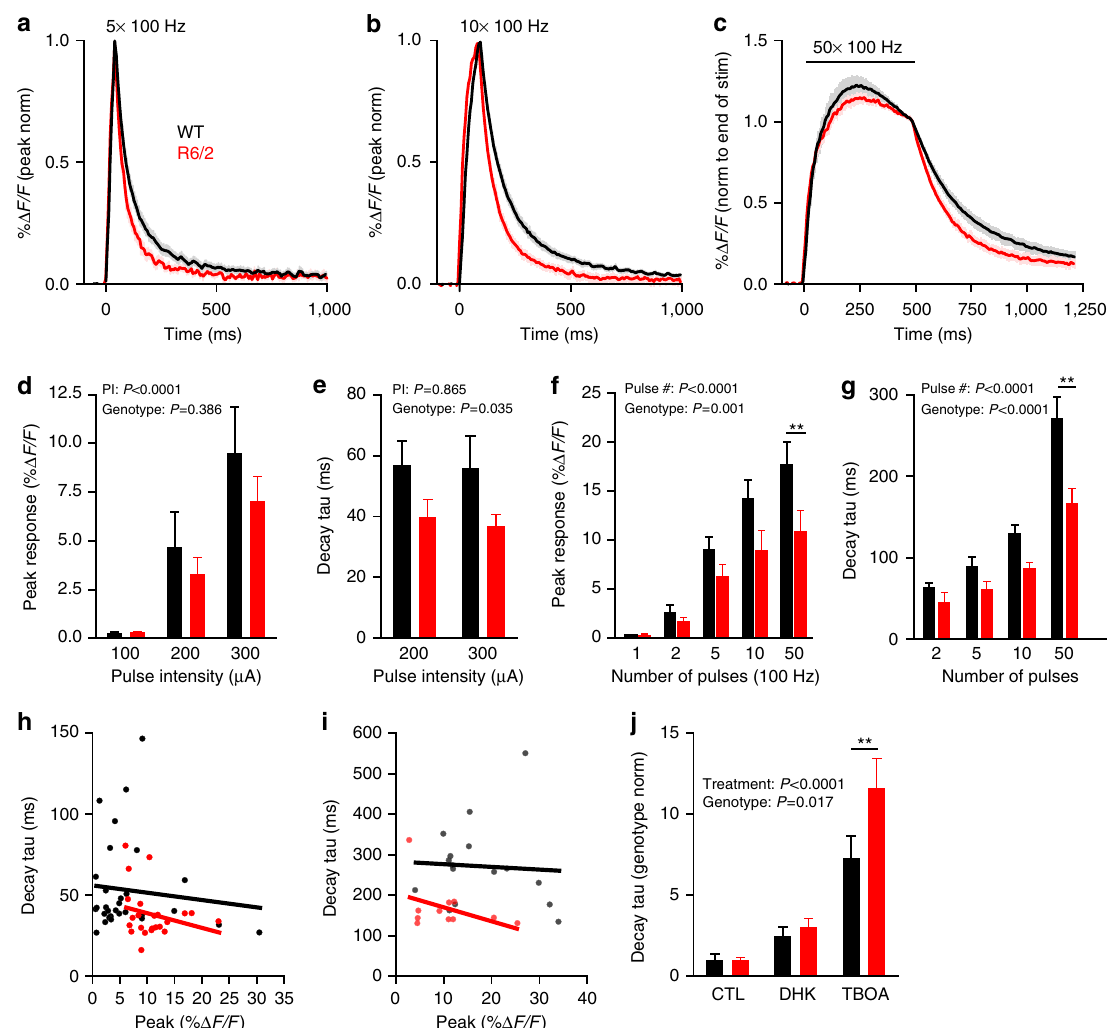
Figure 5 | Extracellular glutamate clearance is accelerated in the R6/2 model of HD at 10 weeks of age. ( a – c ) Grouped data showing the average iGluSnFR response ( ± s.e.m.) to 5 ( a ), 10 ( b ) and 50 ( c ) pulses (100Hz, 100 m A) in the dorsal striatum from 2-month-old WT ( B6CBAF1/J ; black) and age-matched, R6/2 (red) mice. The responses are normalized (norm) to their peaks to simplify comparisons of decay time course. ( d , e ) Bar graphs of response size ( d ) and decay ( e ) to single pulses of varying pulse intensities (PI). WT n ¼ 16 per bar, R6/2 n ¼ 11, 12, 12 for 100, 200, 300 m A, respectively, two-way ANOVA. ( f , g ) Bar graphs of response size ( f ) and decay ( g ) to an increasing number of pulses with 10ms interpulse intervals. WT n ¼ 15, 15, 16, 16, 16 for 1, 2, 5, 10, 50 pulses, respectively, R6/2 n ¼ 11 per bar, two-way ANOVA; ** P o 0.01 Bonferroni post hoc comparison. ( h , i ) Linear regression plots showing no correlation for either WT (black) or R6/2 (red) between iGluSnFR response size and decay tau following a single pulse at 200 m A ( h ; WT r 2 ¼ 0.011, P ¼ 0.575; R6/2 r 2 ¼ 0.059, P ¼ 0.264) or 50 pulses at 100Hz (100 m A, i ; WT r 2 ¼ 0.049, P ¼ 0.829, R6/2 r 2 ¼ 0.170, P ¼ 0.208). ( j ) Bar graph showing the fold-increase in iGluSnFR decay kinetics following a 10-min bath application of the GLT-1-specific blocker dihydrokainic acid (DHK; 250 m M) or the non-selective glutamate transporter inhibitor threo- b -benzyloxyaspartic acid (TBOA; 100 m M). The values are normalized to the genotype average in baseline (untreated) conditions. WT n ¼ 8 per bar; R6/2 n ¼ 6, 6, 5 from left to right; two-way ANOVA. ** P o 0.01 Bonferroni post hoc comparison.